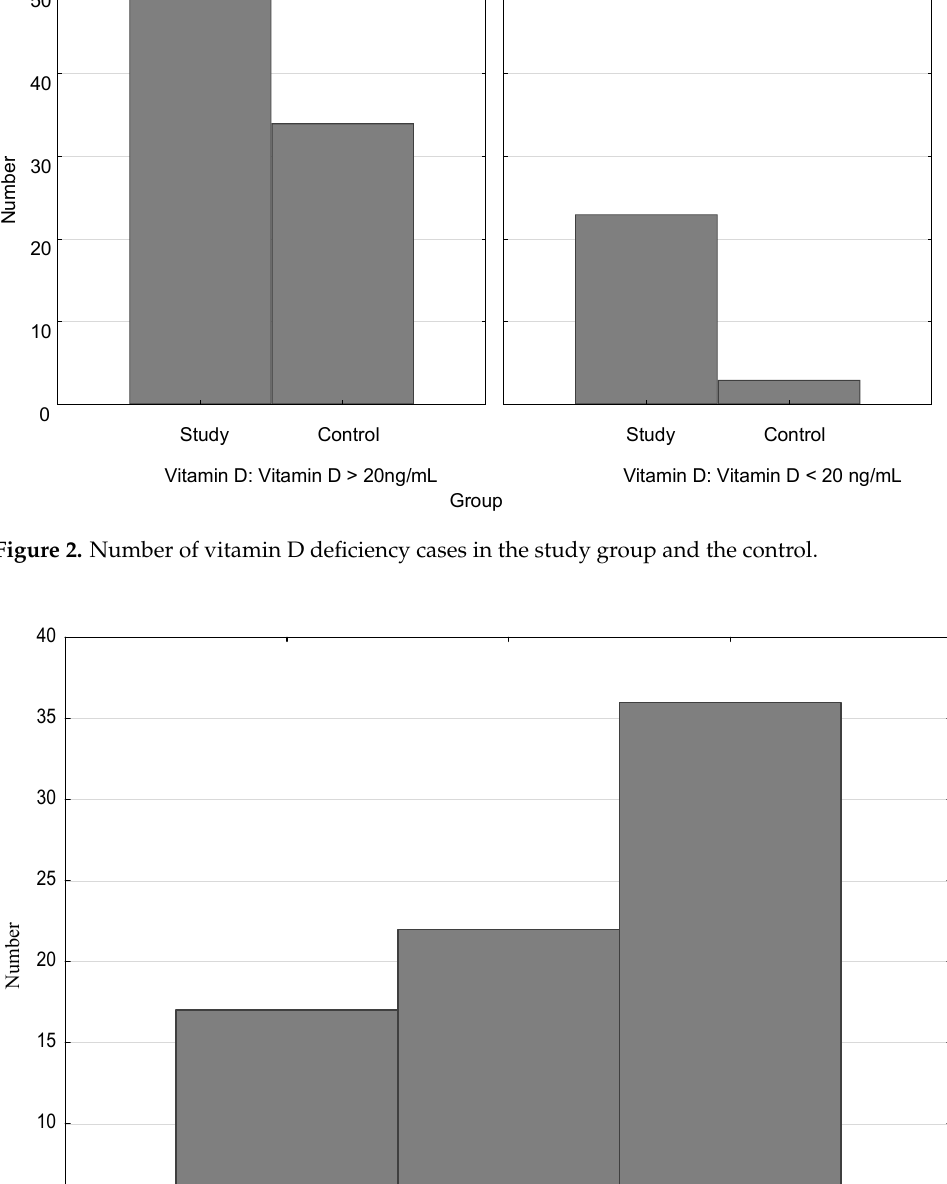
Figure 3. The clinical course of the allergic disease in the study group. Statistically significantly higher vitamin D concentrations were observed in the group of children with a mild course of the disease compared to children with a severe